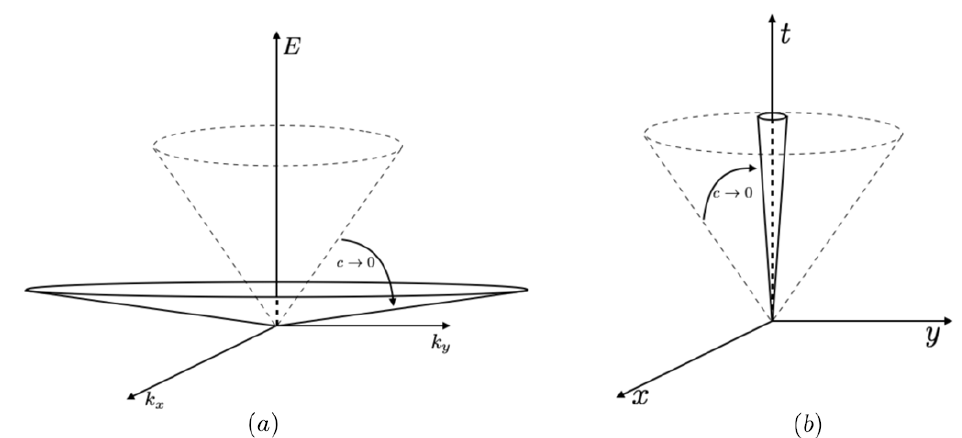
Figure 2 . (a) Flattening out of the momentum space dispersion relation and (b) closing down of space-time light cone c → 0